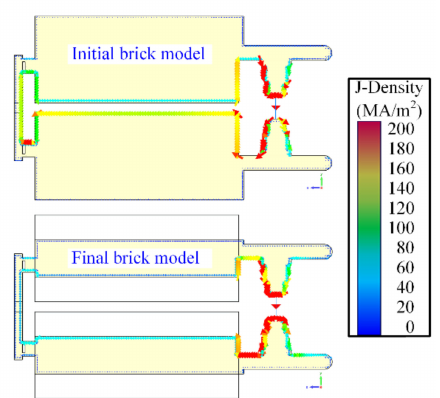
Figure 14. Cross-sectional view of the current density vector at the instant of maximum brick current.